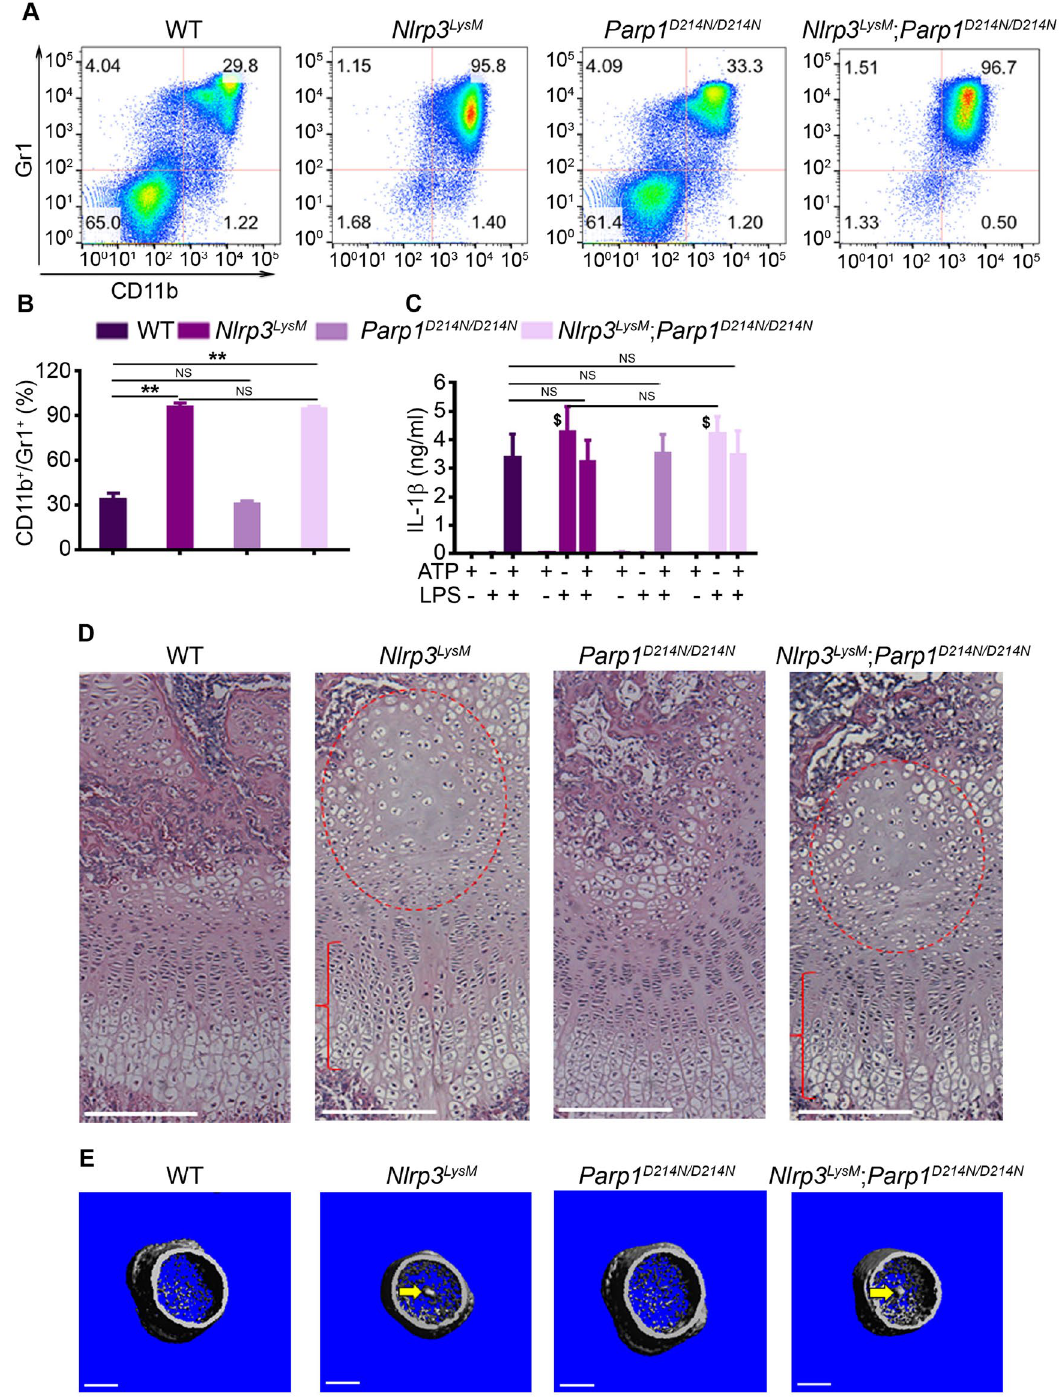
Figure 2. Constitutive activation of the NLRP3 inflammasome in myeloid cells causes inflammation and growth plate defects independently of PARP1. All data were obtained from 2-week old WT, Nlrp3 LysM , Parp1 D214N/D214N or Nlrp3 LysM ; Parp1 D214N/D214N male mice (n = 3–4/genotype). ( A ) Red blood cell-depleted bone marrow cells were stained with isotype control (data not shown) or with antibodies against CD11b and Gr1. Representative flow cytometry dot plots of the CD11b + /Gr1 + myeloid cells from each genotype are shown. ( B ) The percentage of CD11b + /Gr1 + cells in bone marrow cells. Data are expressed as mean ± SEM. ** P < 0.005. NS, not significant. ( C ) IL-1 β levels in conditioned media from BMM treated with 100 ng/ml LPS for 3 hours, then with 5 mM ATP for 30 minutes. Data are representative of at least three independent experiments and expressed as mean ± SEM. $ P < 0.001 vs. WT + LPS. ( D ) H&E staining. Red circle and bracket indicate areas of hypocellularity within the enlarged center of the epiphysis and growth plate disorganization, respectively. Scale bar, 150 µ m. ( E ) 3D μ CT reconstruction of distal femoral metaphysis. Scale bar, 0.5